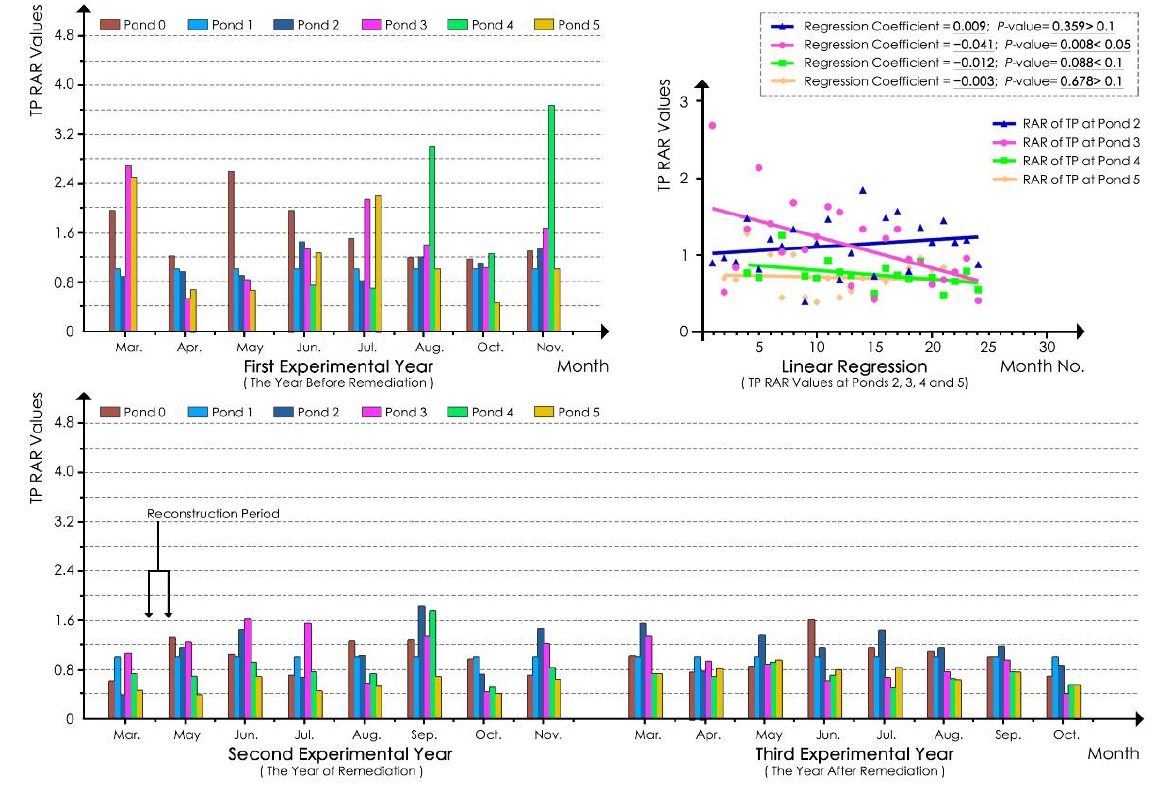
Figure 6. TP RAR values for each pond. Table 8. Statistics of the RAR of the quarterly average TP value 1 at each